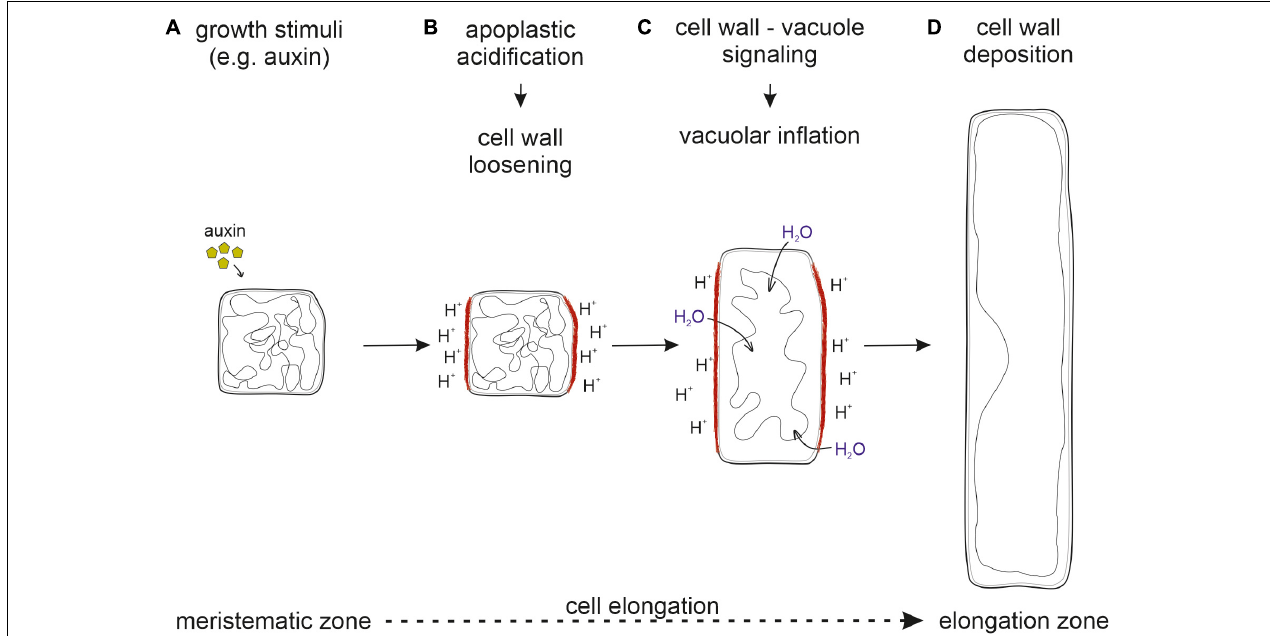
FIGURE 2 | Sequential order of processes necessary for cell elongation. (A) Upon perception of growth stimuli, (B) the apoplast is acidified and the cell wall loosened. (C) The cell wall status is sensed by the FER-LRX module and transmitted into the cell. (D) New cell wall material deposition allows for cell elongation. Inhibition at any step prevents proper cell elongation and inhibits